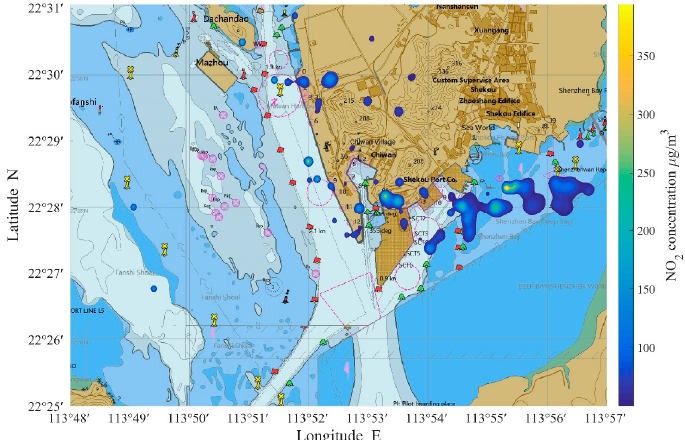
Figure 13. NO 2 concentration distribution at 3:00 (greater than 50 μ g/m 3 ).